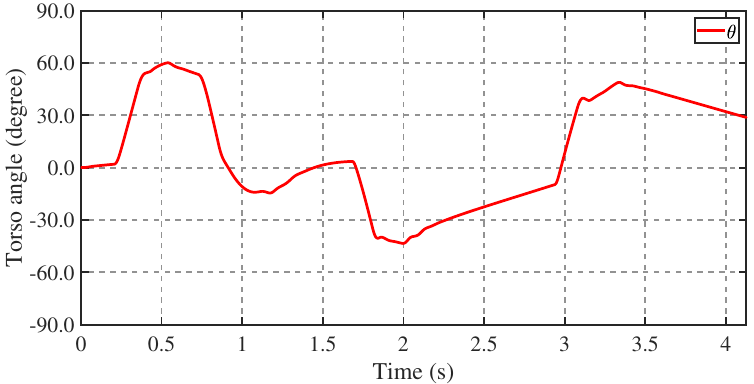
Figure 10. Trajectory of the torso angle when the robot slides on uneven terrain.